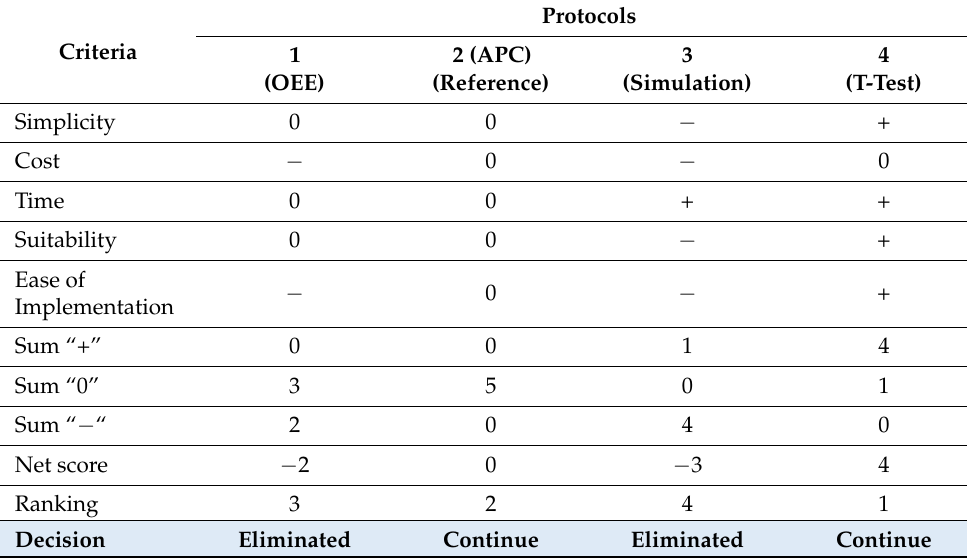
Table 11. Summary of the protocol screening results from Protocols 1 to